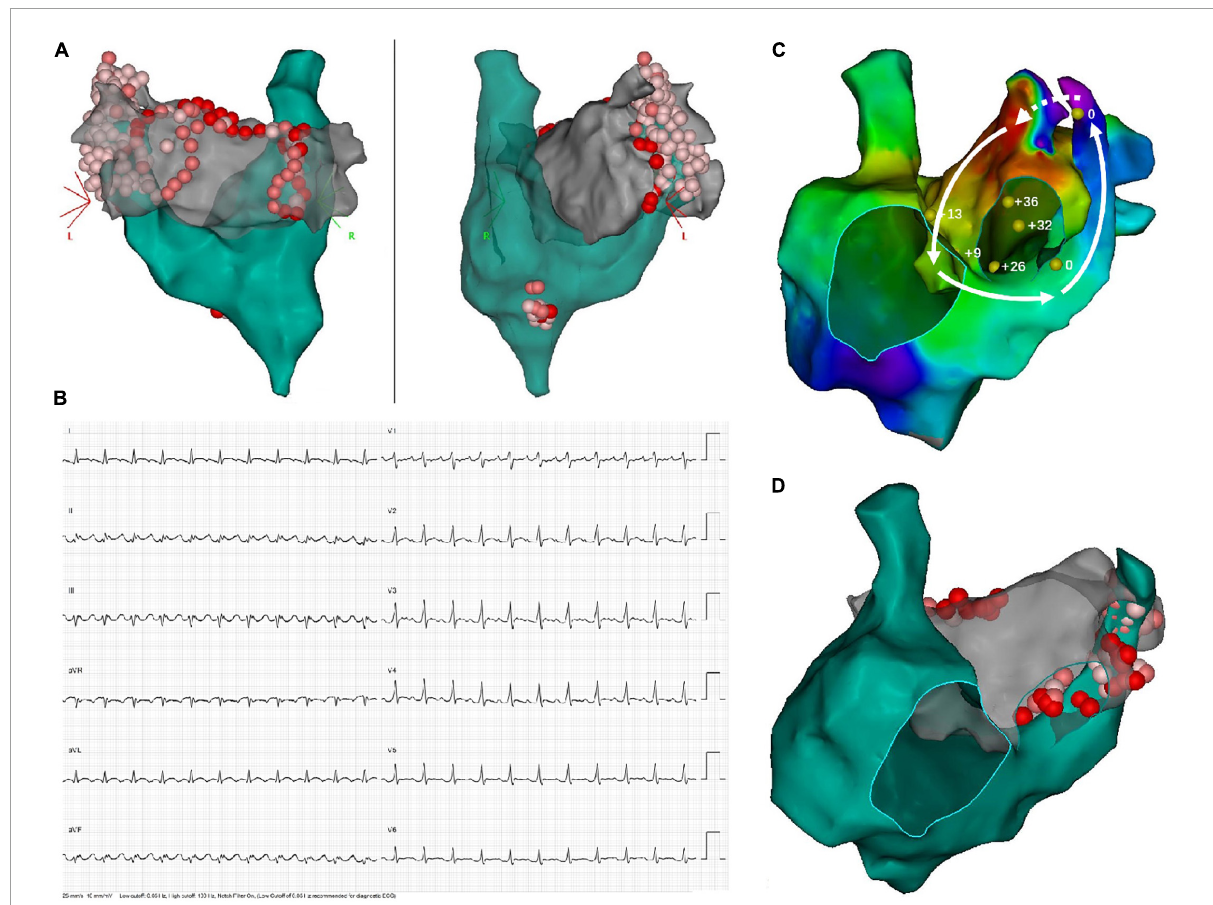
FIGURE3 Demonstration of twice ablation procedure in a patient with persistent AF and PLSVC. (A) In the first ablation procedure, PVI, as well as linear ablation at the LA roofline, MI line, and CTI line was performed. Extensive ablation targeting LA-PLSVC and CS-PLSVC connection, as well as high-frequency signals inside PLSVC, resulted in PLSVC isolation. (B) ECG of recurrent atrial flutter (AFL). (C) Bi-atrial AFL involving a connection between PLSVC and left atrial appendage. Sites where entrainment mapping was conducted were indicated by yellow dots, with the numerical value of post-pacing interval minus tachycardia cycle length (PPI-TCL) labeled by white numbers. The dotted arrow indicated conduction through epicardial connections between the left atrial appendage (LAA) and PLSVC, while the solid lines with arrowhead indicated conduction pathway through LAA, the anterior wall of LA, interatrial septum, septal aspect of the right atrium, coronary sinus and PLSVC. (D) Repeated ablation targeting resumed LA-PLSVC connections, as well as touch-up ablation at the roofline, was conducted in the